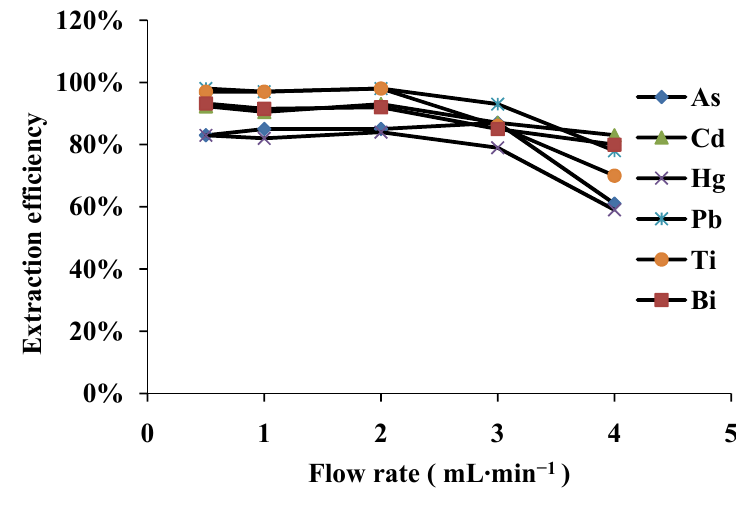
Figure 2. Effect of sample flow rate on extraction efficiency of the analytes As, Bi, Cd,